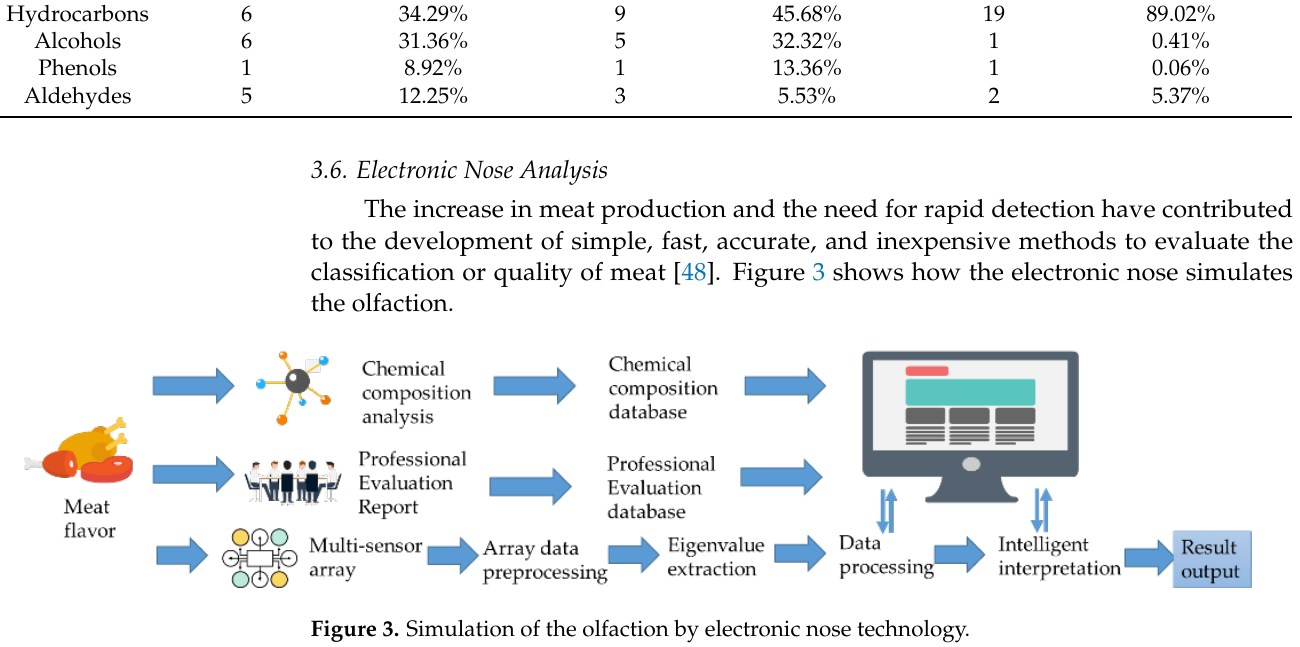
Table 6. Comparison of the VOCs of different types of chicken breast.